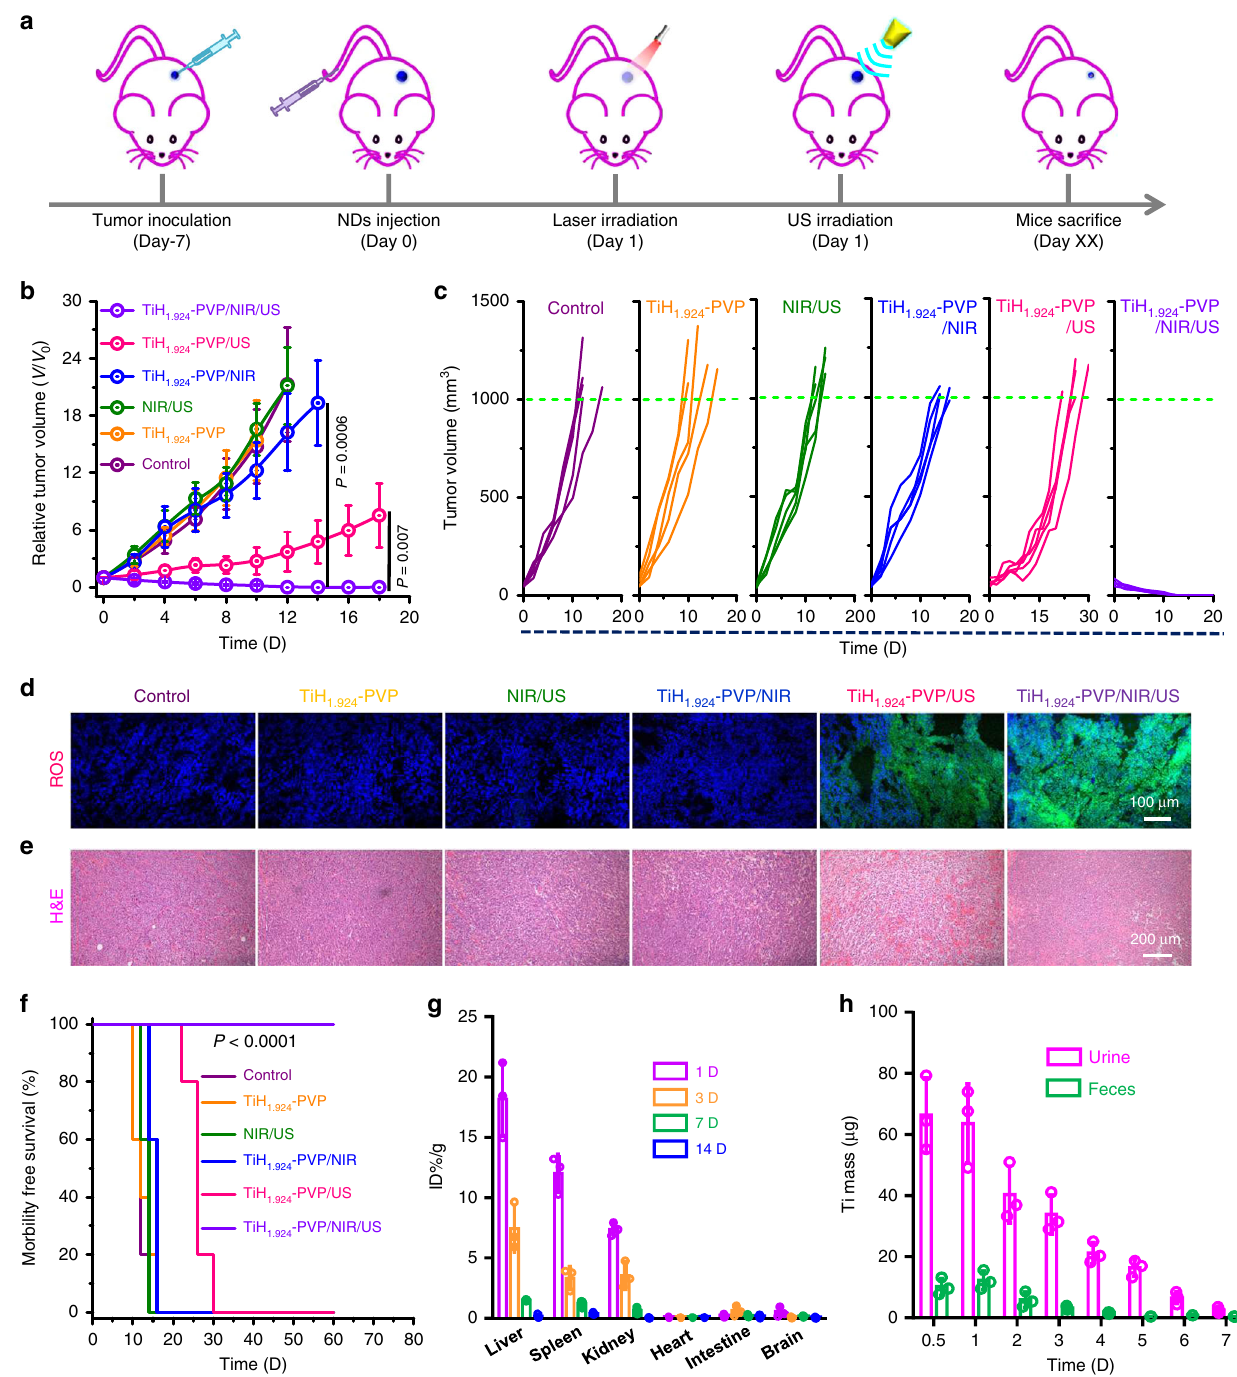
Fig. 6 In vivo mild PTT-enhanced SDT via TiH 1.924 -PVP. a Schematic illustration to show the combination of PTT and SDT with TiH 1.924 -PVP nanodots. b , c Average tumor growth curves ( b ) and individual tumor growth curves ( c ) on mice after different treatments, including control, TiH 1.924 -PVP, NIR/US, TiH 1.924 -PVP/NIR, TiH 1.924 -PVP/US, and TiH 1.924 -PVP/NIR/US ( n = 5 biologically independent mice). d Micrograph of DCFH-DA stained tumor slices collected for mice receiving different treatments. e H&E stained tumor slices collected from different treatment groups. f Survival curves of mice after various treatments. g Biodistribution of TiH 1.924 -PVP post i.v. injection in mice on different days ( n = 3 biologically independent mice). h The detected Ti mass in urine and feces at different time points post i.v. injection of TiH 1.924 -PVP ( n = 3 biologically independent mice). The Ti contents were measured by A representative image of three biological replicates from each group is shown in d , e . Data are presented as mean values± SD. Statistical signi fi cance